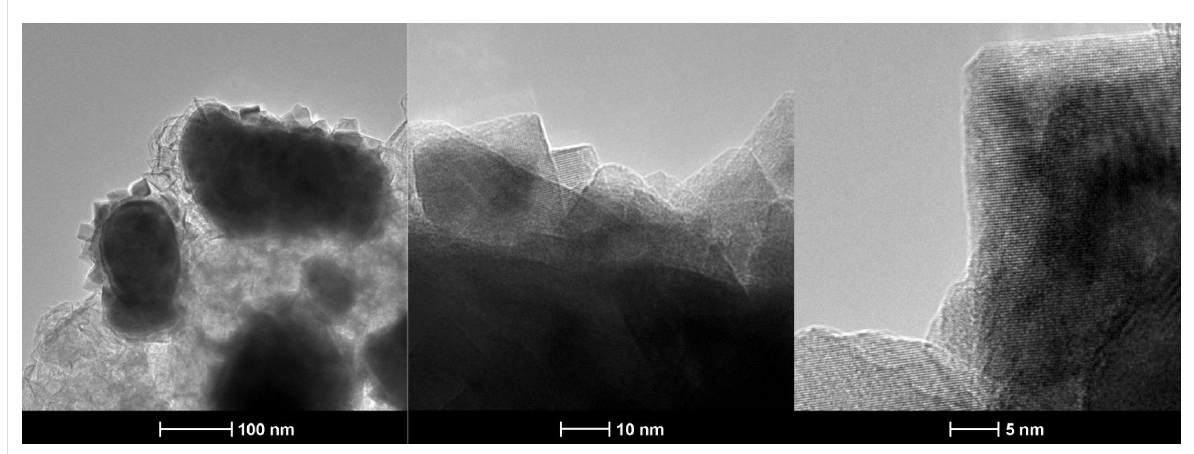
Only the (110) and (200) peaks corresponding to bcc-Fe are observed. XRD characterization of the recycled nanoparticles after each run of catalysis demonstrated that the crystallinity of